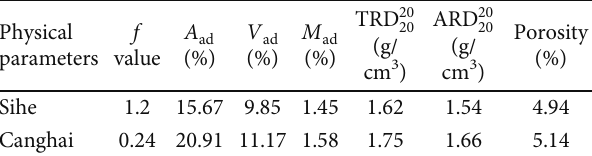
Figure 1: Geographic locations of the coal sampling sites. Table 1: Physical parameters of the two coal